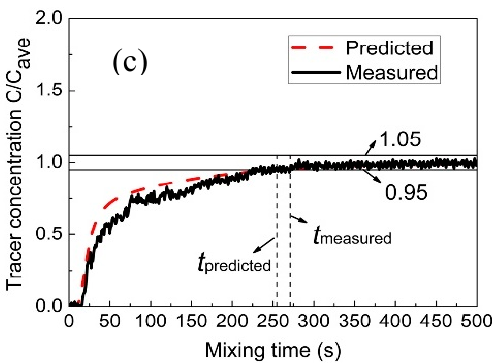
Figure 5. Measured and predicted tracer dimensionless concentration of measuring points ( a ) M1, ( b ) M6, and ( c ) M13 with time in bath.